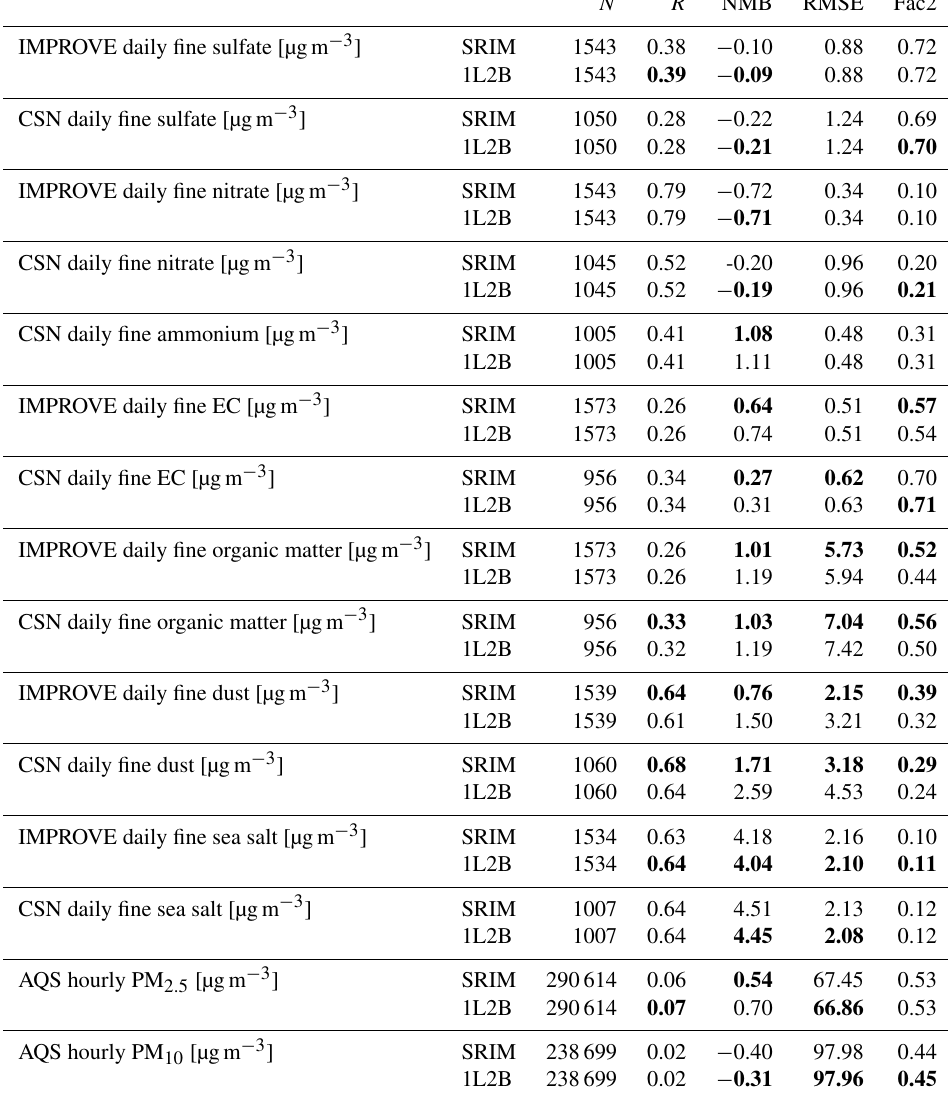
Table 4. Evaluation of SRIM and 1L2B simulations against observations. N is the number of model–observation pairs, R is the correlation coefficient, NMB is the normalized mean bias, RMSE is the root mean square error, and Fac2 is the fraction within a factor of 2. Better performance between SRIM and 1L2B (larger values of R and Fac2 and smaller values of NMB and RMSE) is shown in bold font.